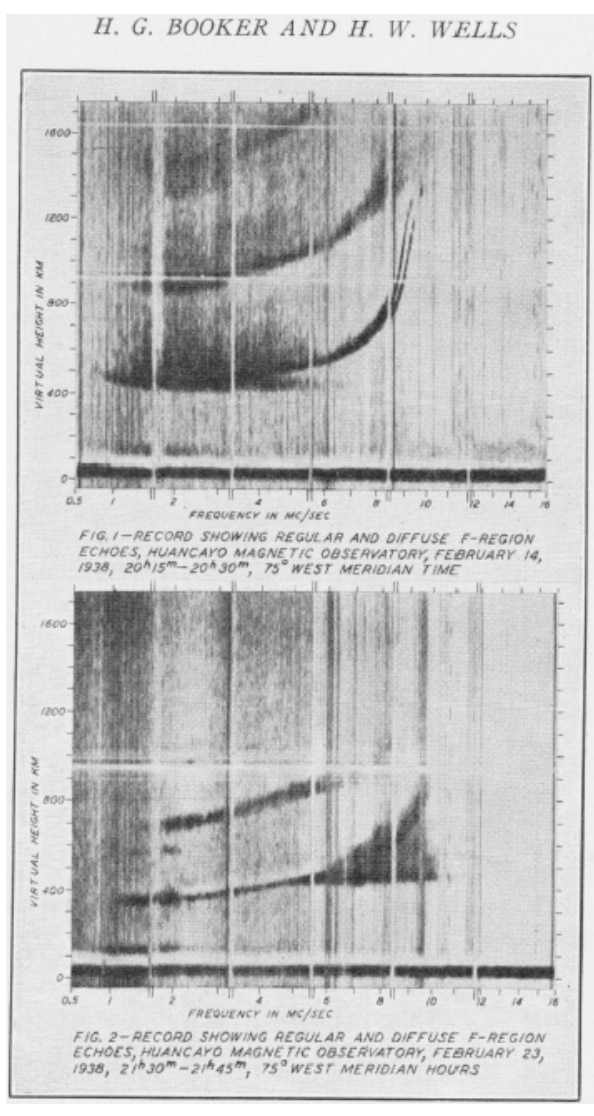
Fig. 1. First published ionogram showing Spread F (after Booker Figure 1. First published ionogram showing Spread F (after Booker and Wells, 1938) and Wells,